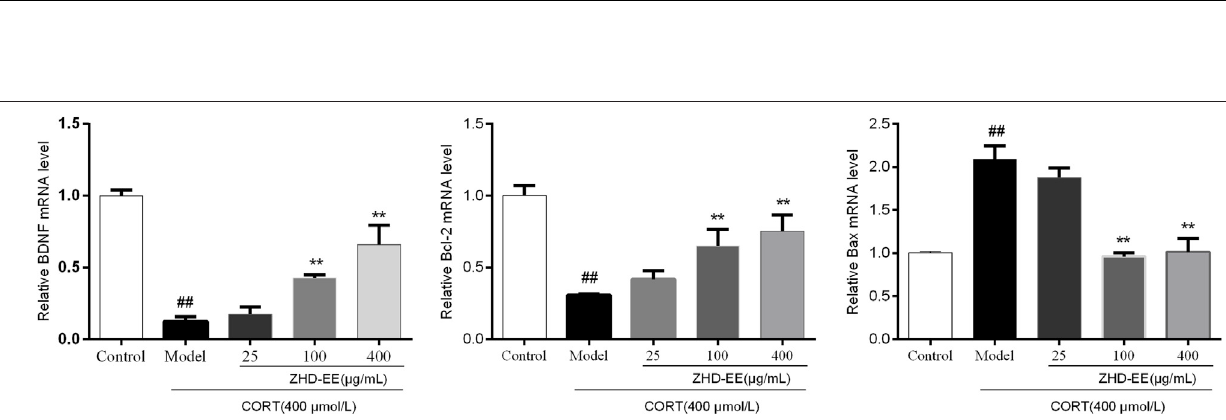
Frontiers in Pharmacology |